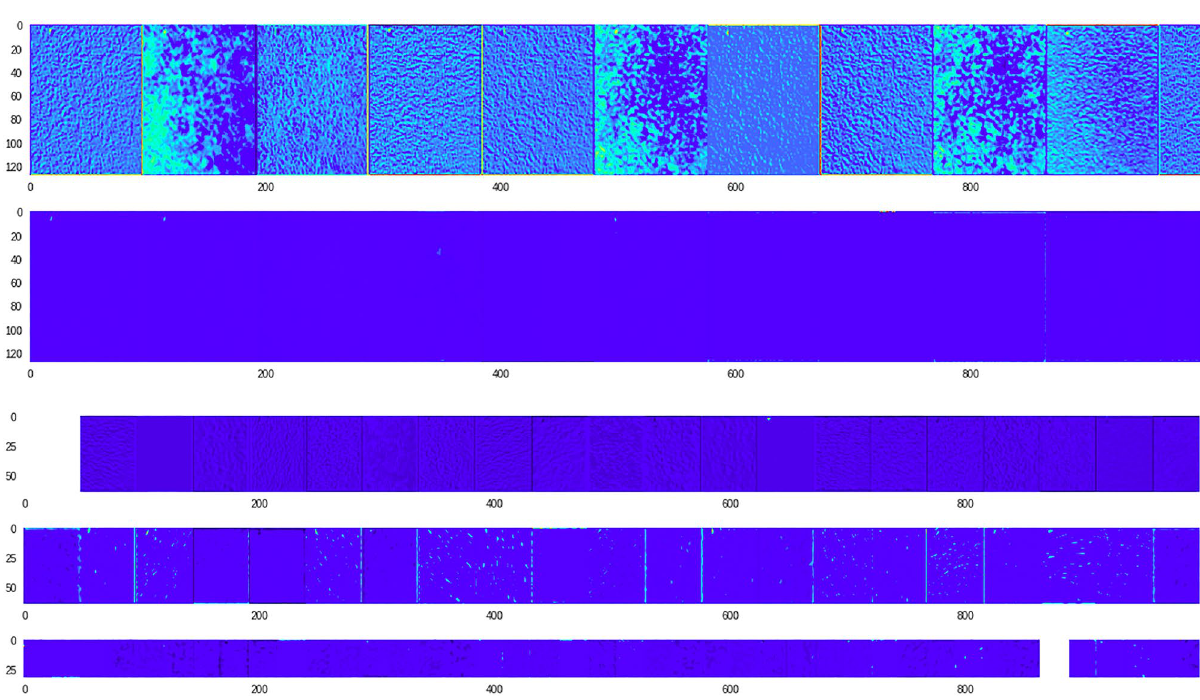
Figure 20. Image from ‘liver’ class producing mixed response from MS & VML but unequivocal response from IML (Figure generated by Matplotlib python library, version 3.3.4, https:// matpl otlib. org/).